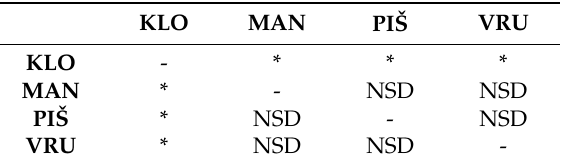
Table 6 . Results of the t-test of the δ 13 C values of the muscle tissues (NSD = no statistical difference, * = statistical significance at a confidence level of p ≤ 0.05).